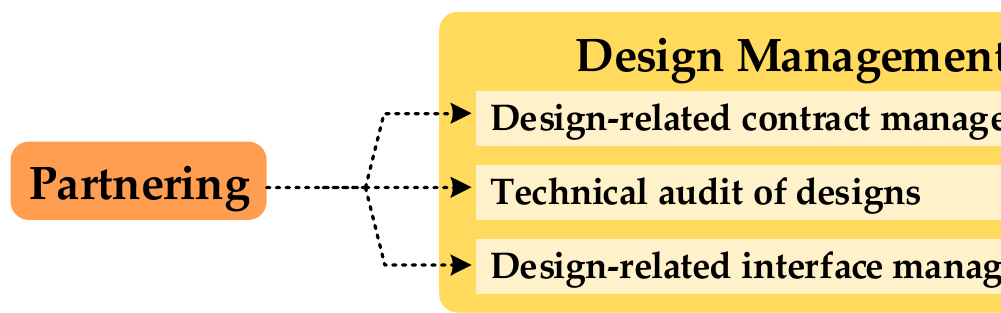
Figure 3. Relationship between partnering and design management.